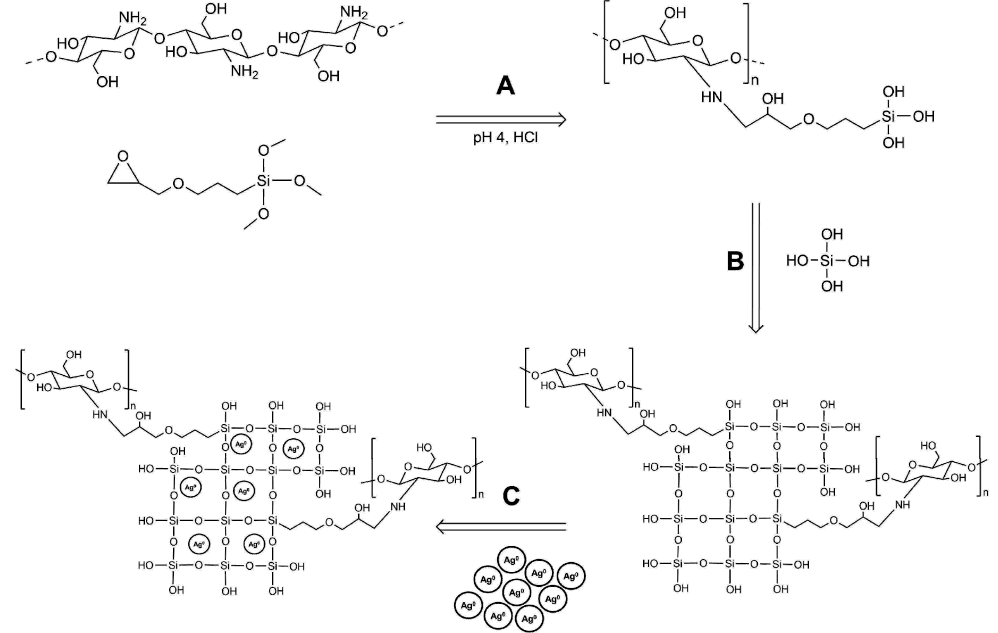
Figure 2. Chemical synthesis of chitosan–silica Class II hybrids and imbedding of silver nanoparticles (AgNPs). ( A ) Coupling of chitosan and 3-glycidyloxypropyltrimethoxysilane (GPTMS) in mildly acidic conditions; ( B ) polycondensation of coupled chitosan and hydrolyzed tetraethoxysilane (TEOS); ( C ) imbedding AgNPs into the hybrid sol network.